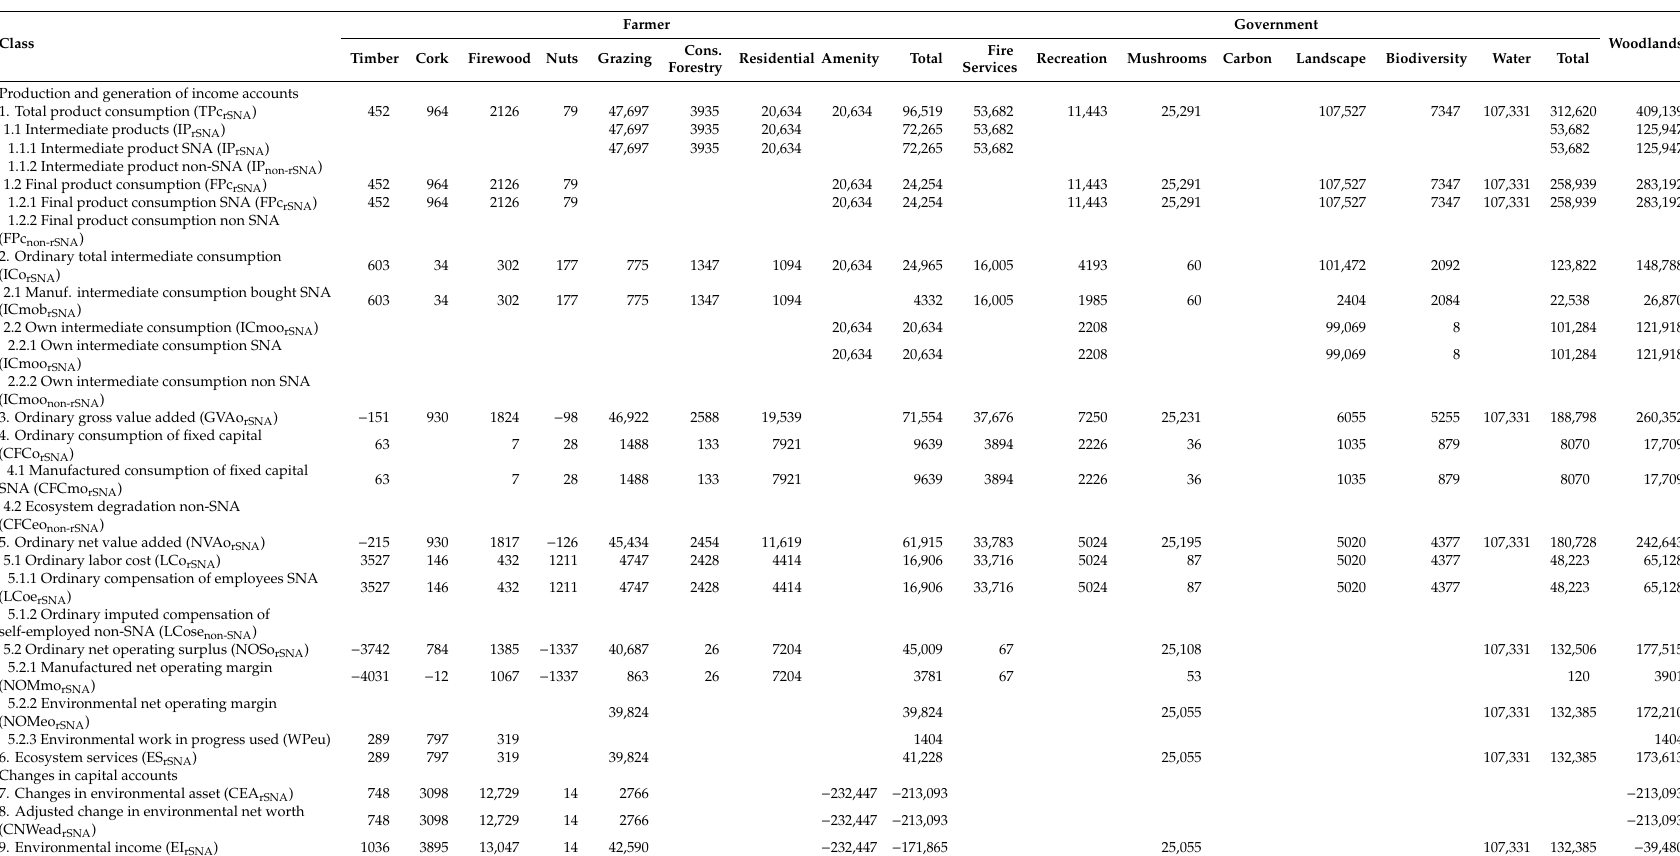
Table A2. Stylized sequence of accounts of the refined System of National Accounts applied in holm oak open woodlands in Andalusia, Spain (2010: thousands of